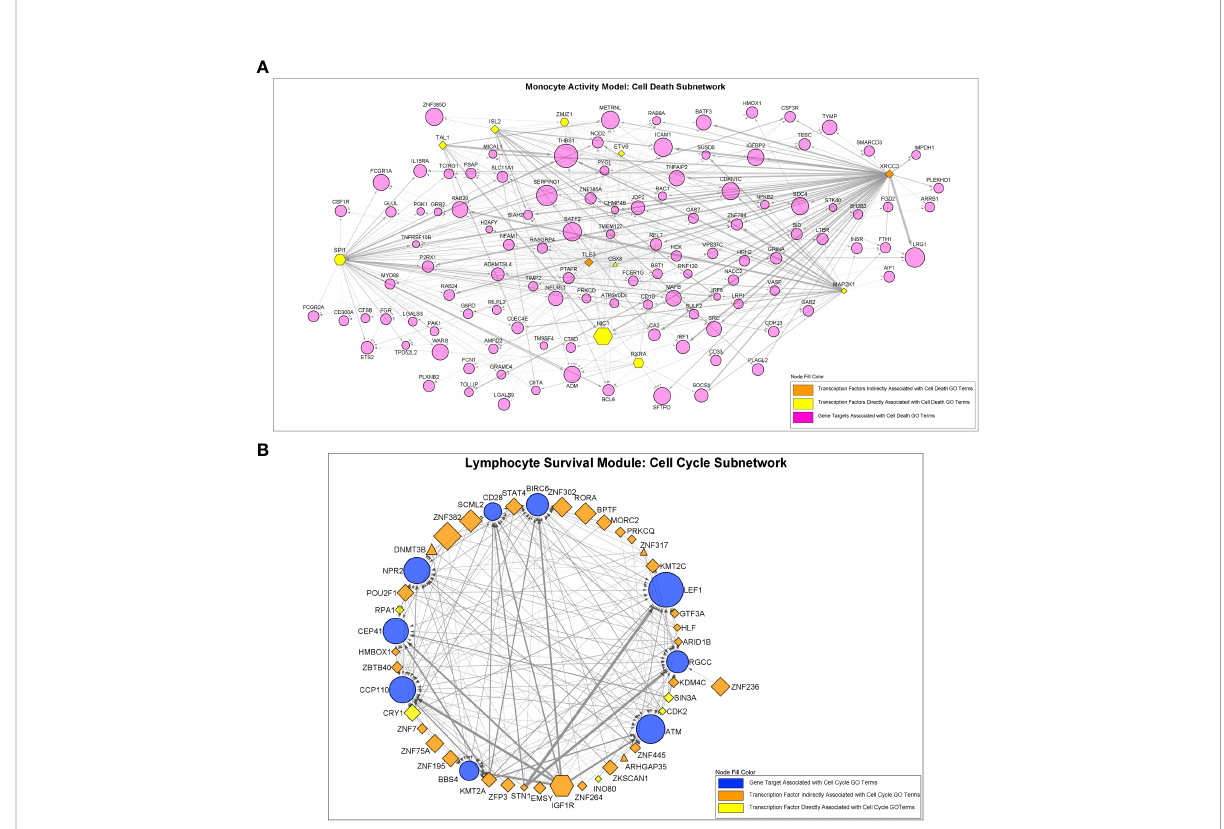
FIGURE 5 Regulatory interactions between transcription factors and target genes in the “ Cell Death ” and “ Cell Cycle ” subnetworks. (A) The MAM cell death subnetwork was comprised of a total of 123 nodes and 557 edges. Nodes consisted of 11 transcription factors with signi fi cantly altered regulatory activity and 112 target genes. (B) The LSM cell cycle subnetwork was comprised of a total of 45 nodes and 210 edges. Nodes consisted of 36 transcription factors with signi fi cantly altered regulatory activity and 9 target genes. For (A, B) , all transcription factors demonstrated signi fi cant differential transcription factor involvement (DTFI). Transcription factors are shown as hexagonal nodes if differentially over-expressed in MAM or differentially under-expressed in LSM and as rhomboid nodes if stably expressed (triangle shaped nodes in LSM represent 3 stably over-expressed transcription factors). Transcription factor color indicates direct or indirect relation with cell death or cell cycle GO terms. Target genes are depicted as magenta circles in (A) and blue circles in (B) . For all nodes in (A, B) , size is proportional to absolute log 2 -fold change based on differential expression analysis. Edges in (A, B) indicate an interaction between a transcription factor and target gene. Edge width represents the difference in weight of interaction between sarcoidosis cases and controls as determined by the Monster algorithm. MAM and LSM subnetwork structure is also depicted in Supplemental Tables S5A,